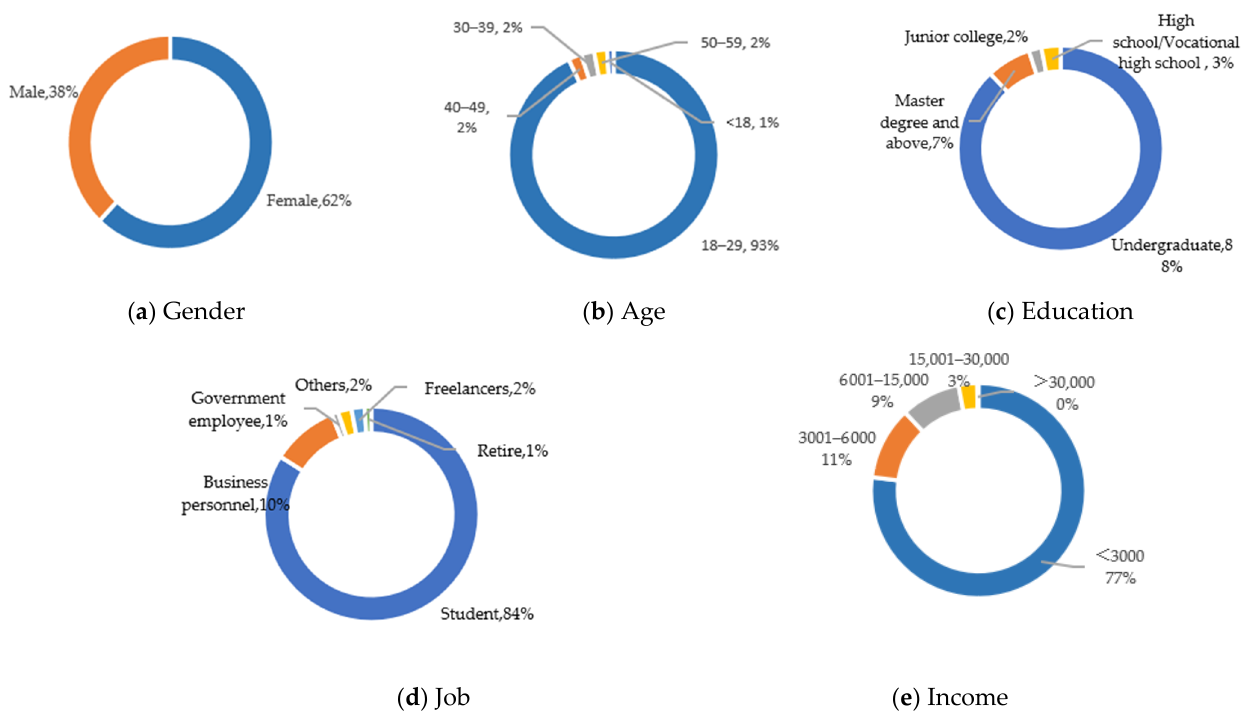
Figure 7. Demographic basic data indicator chart.